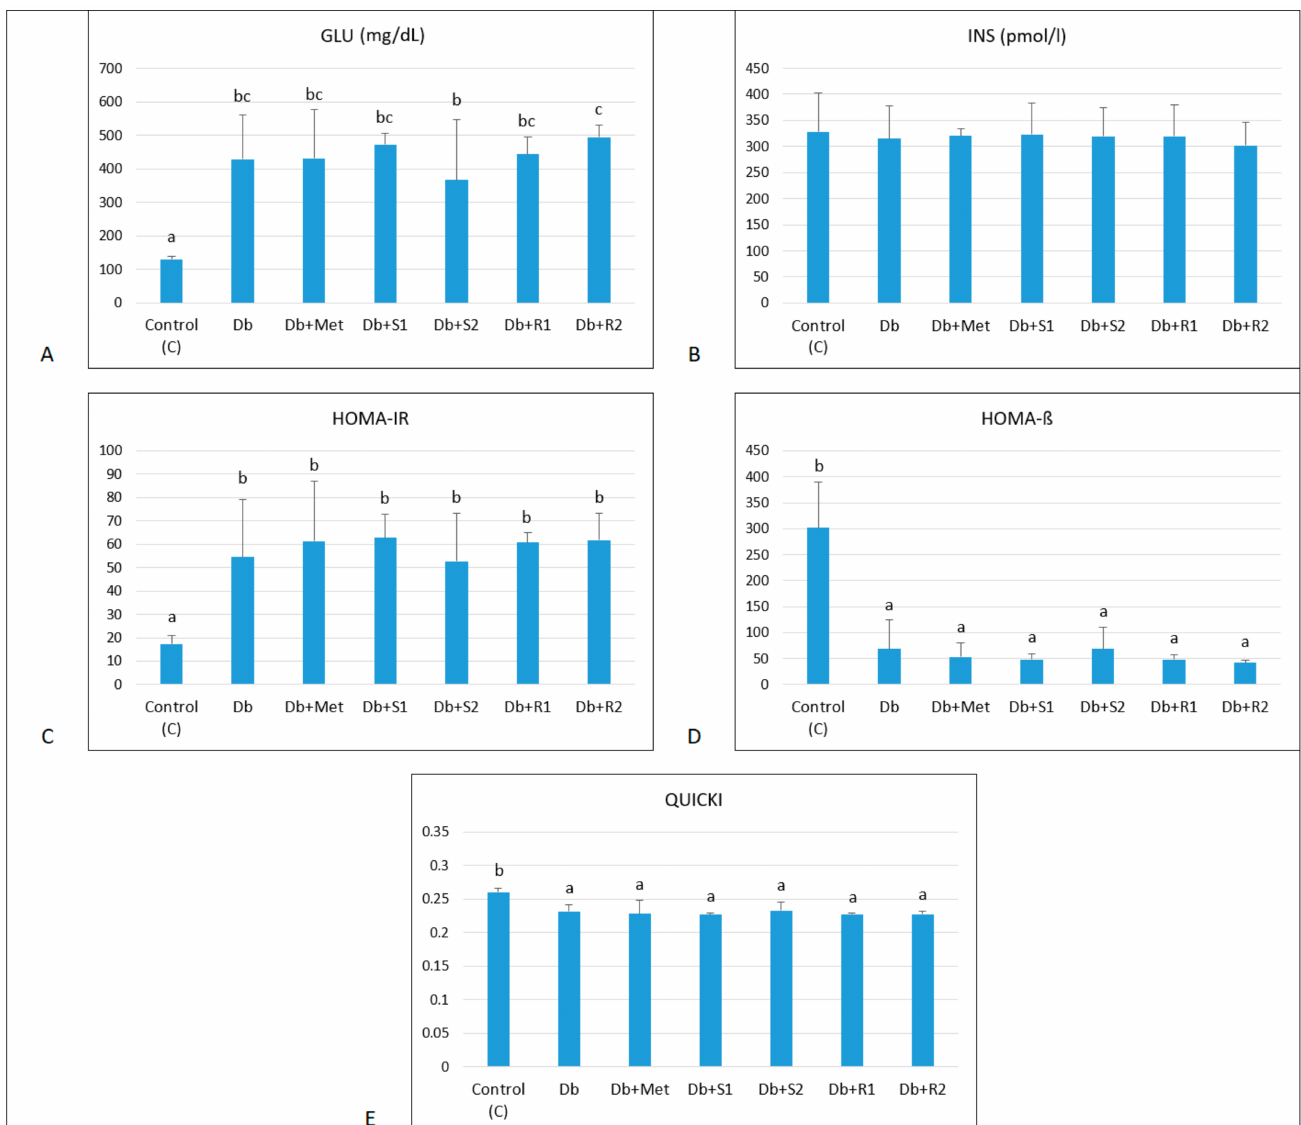
Figure 3. Effect of diet and supplementary SGs on ( A ) GLU: fasting glucose concentration, ( B ) INS: insulin concentration, ( C ) HOMA-IR: insulin resistance index, ( D ) HOMA- β : β -cell function index and ( E ) QUICKI: the quantitative insulin sensitivity check index in rats. Data are presented as mean ± standard deviation (M ± SD). Values with different letters (a–c) show statistically significant differences ( p < 0.05, a < b, Fisher’s LSD